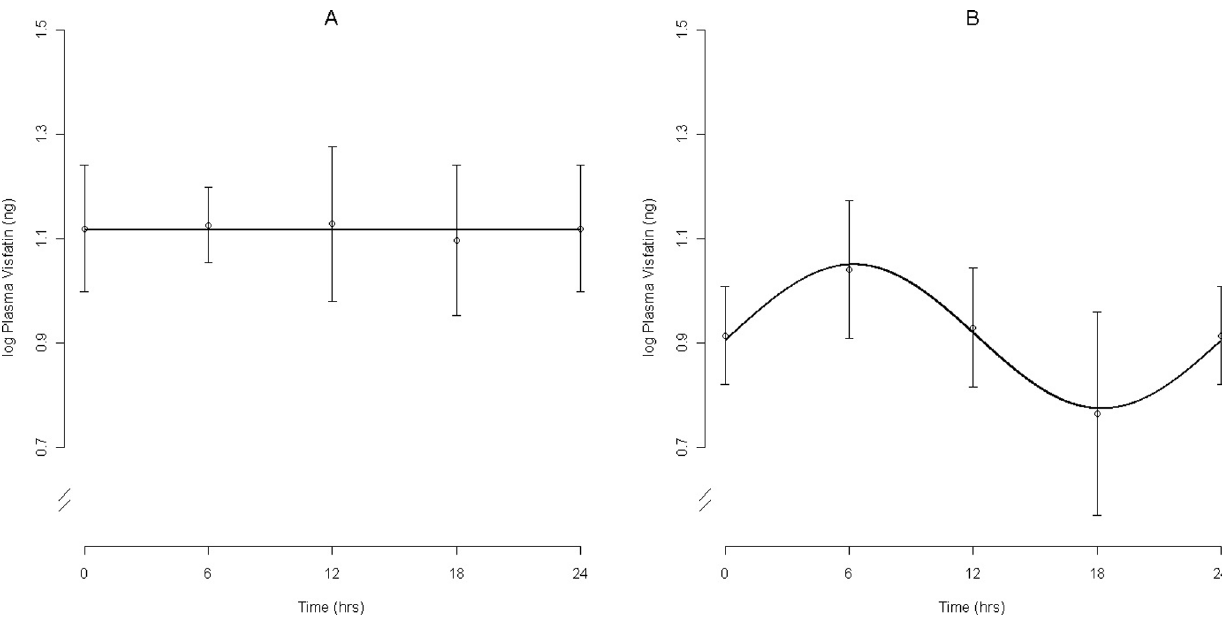
Figure 4. Expression of Visfatin. Levels of visfatin in plasma of non-migrating (A) and migrating (B) white-throated sparrows. For all birds, lights came on at ZT0 and went out at ZT 12. Migrating individuals as a group trended towards rhythmicity ( p , 0.10) with maximum concentrations at ZT6 and minimum concentrations at ZT18. Plasma levels in non-migrating birds were approximately 20% higher than those of migrating birds.